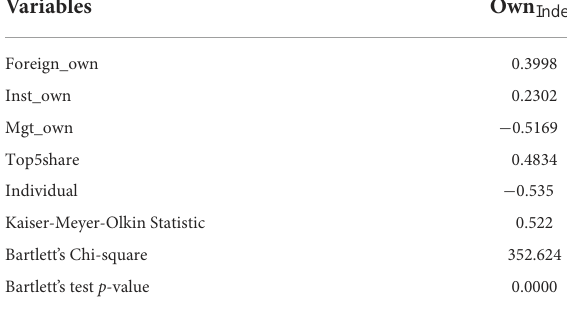
TABLE 6 Ownership structure and dividend